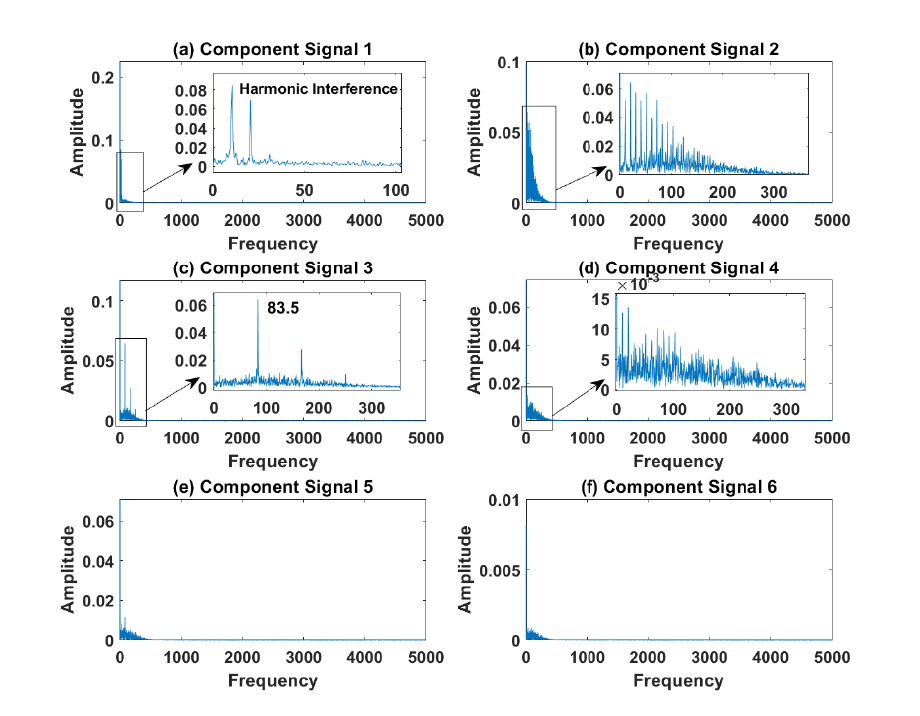
Figure 16. Decomposition results of ISVDP with m = 16 and J = 3: ( a – f ) envelop of 1st to 6th subcomponents, respectively.